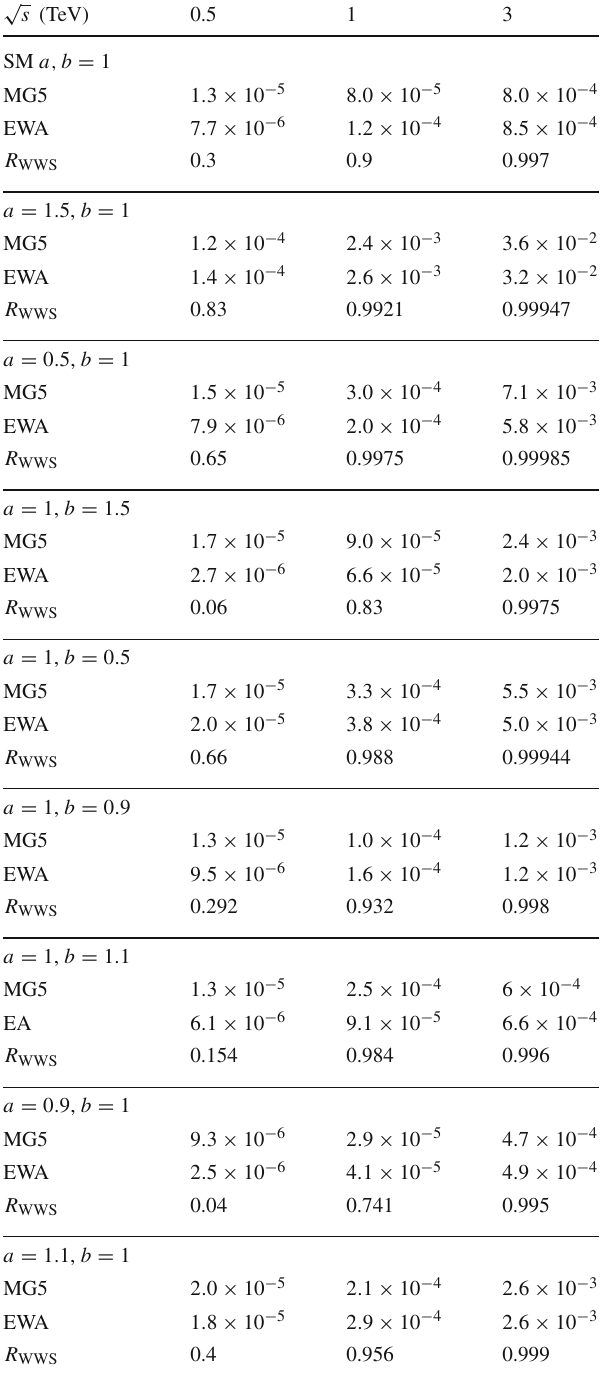
Table 2 Predictions of the cross sections σ( e + e − → H H ν e ¯ ν e ) (in pb) withintheEChLfordifferentvaluesoftheparameters a and b and e + e − CMenergies.TheSMcase( a = b = 1)isalsoincludedforcomparison. The predictions from both MG5 and the EWA are displayed, as well as the ratio R WWS , defined in Eq. (8), which quantifies the relevance of the WWS within the whole e + e − process